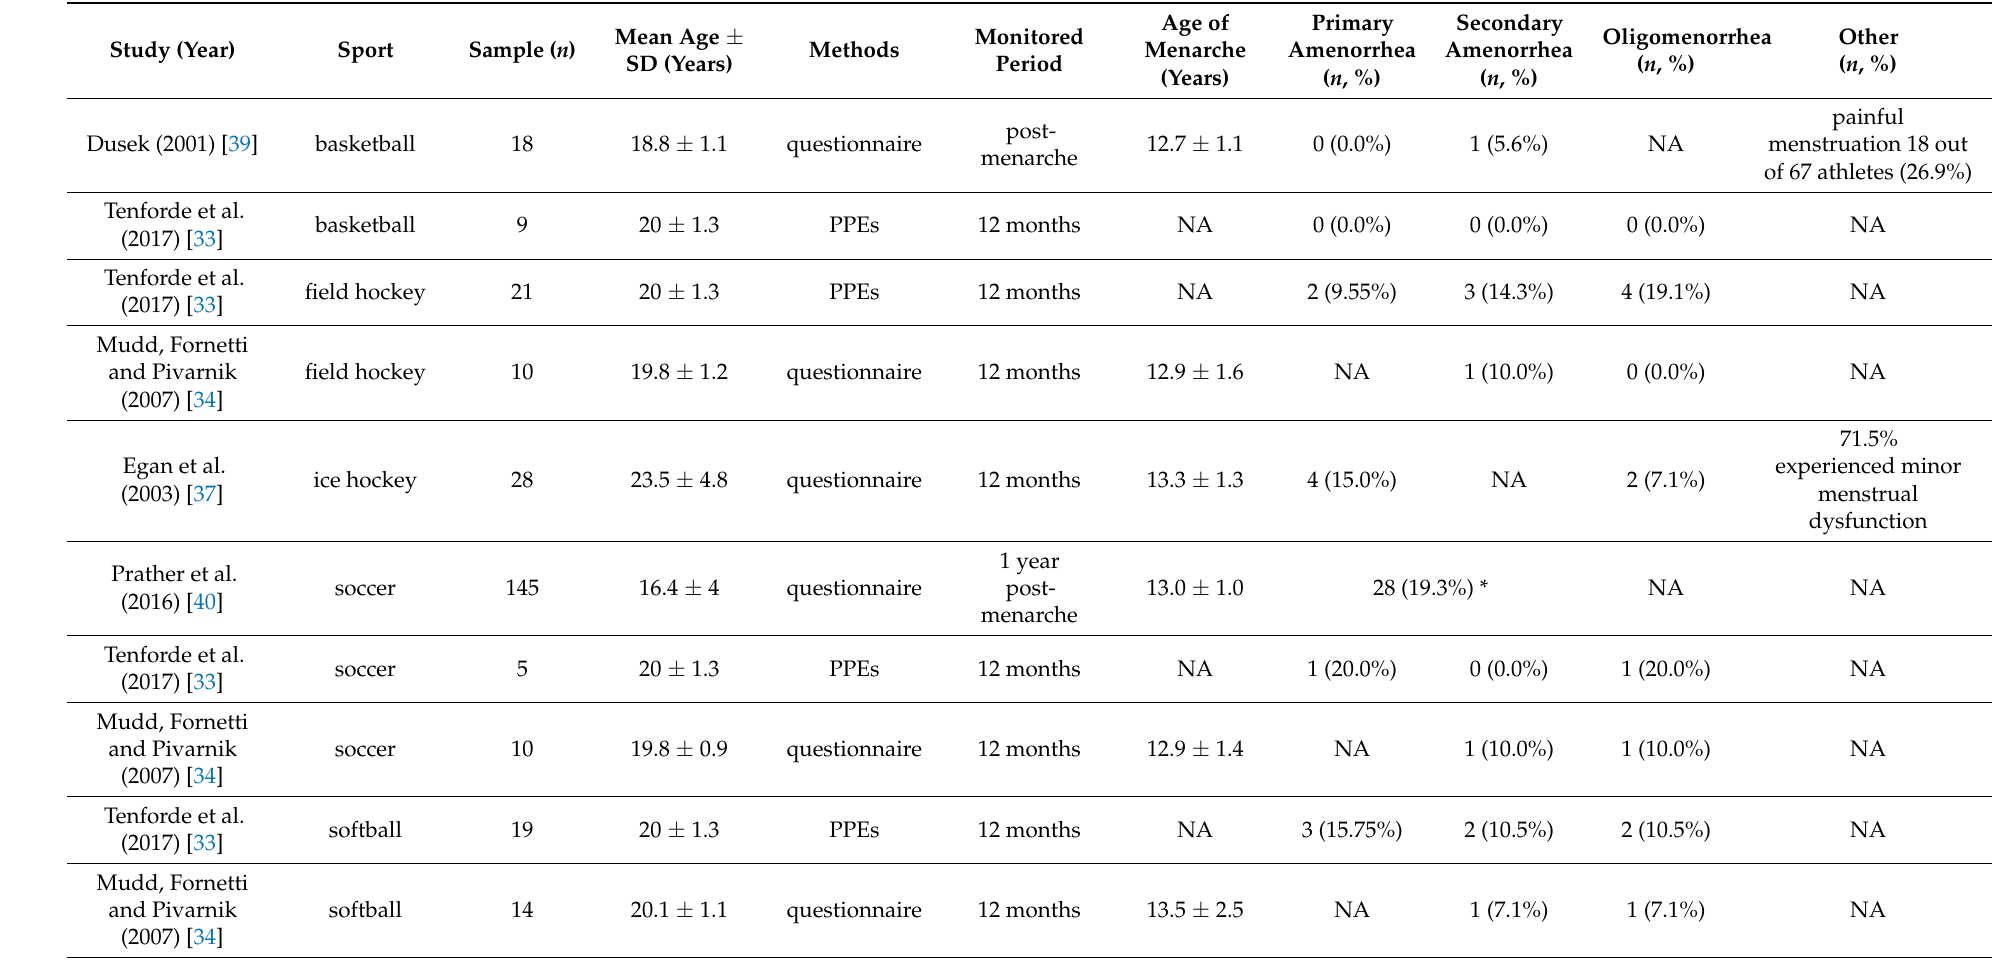
Table 2. Sample characteristics, menstrual disorders measurement and prevalence in team